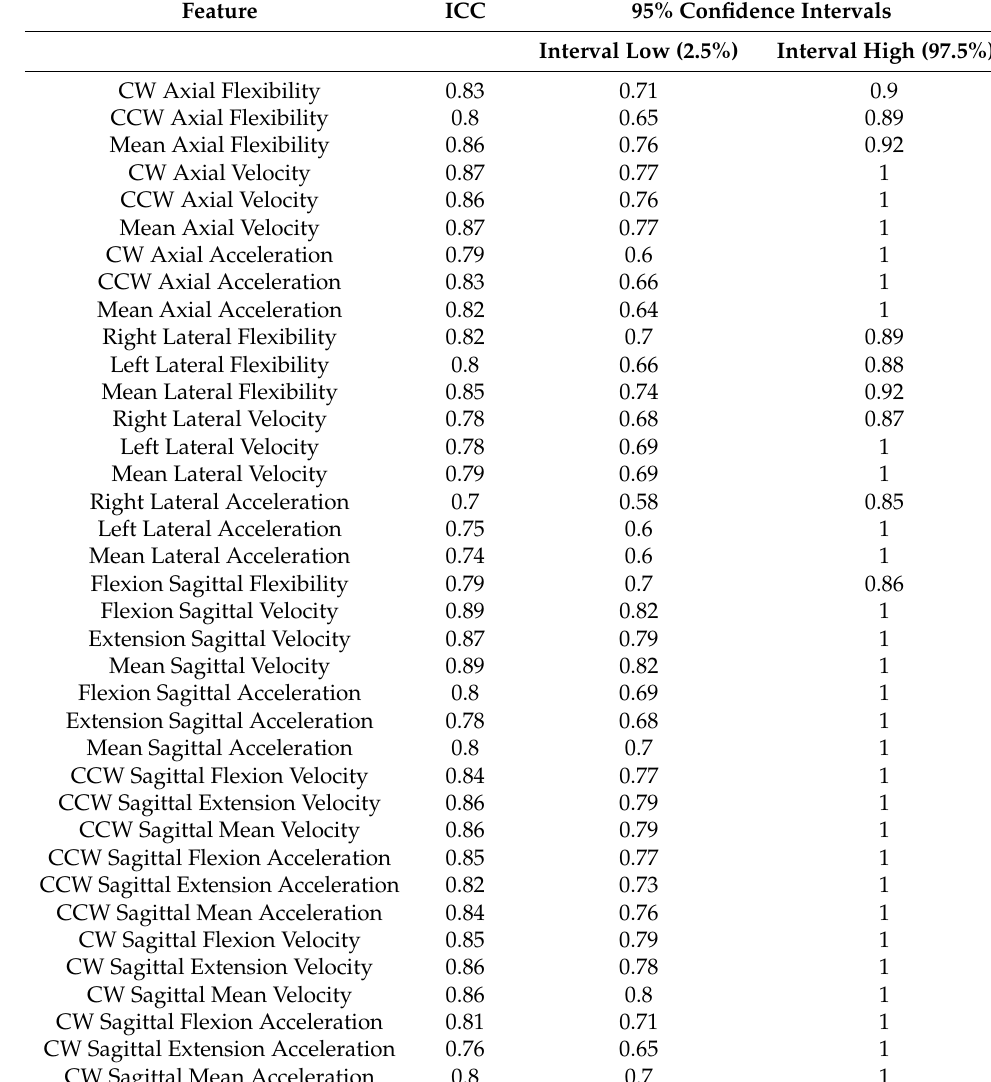
Table 4. ICC values estimated for inter-rater reliability of all